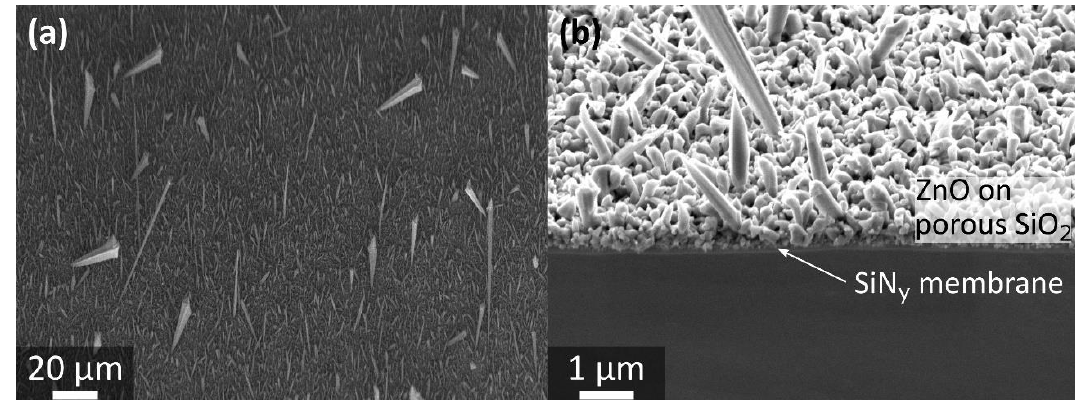
Figure 4. Catalyst-assisted ZnO NW growth on free-standing membranes. ( a ) Large ZnO nanowires, surrounded by shorter needles, were observed on the free-standing membranes. ( b ) The cross section through the free-standing membrane with porous SiO 2 and ZnO structures on top was generated by focused ion beam milling (30 kV, 50 pA). The SEM images were taken at an angle of 54° with the Crossbeam 550 by Zeiss.